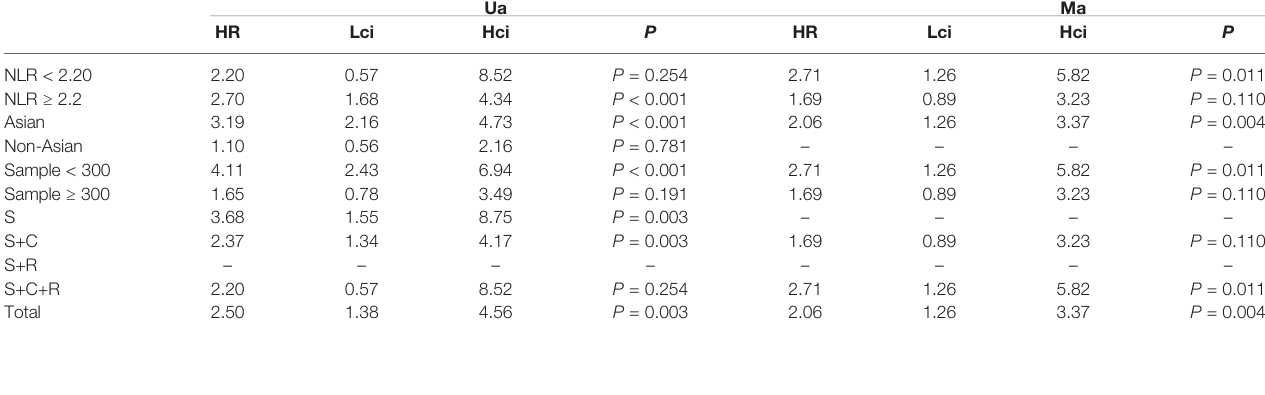
TABLE 3 | The results of the subgroup analysis for neutrophil – lymphocyte ratio (NLR) and disease-free survival are summarized below. Ua Ma HR Lci Hci P HR Lci Hci P NLR < 2.20